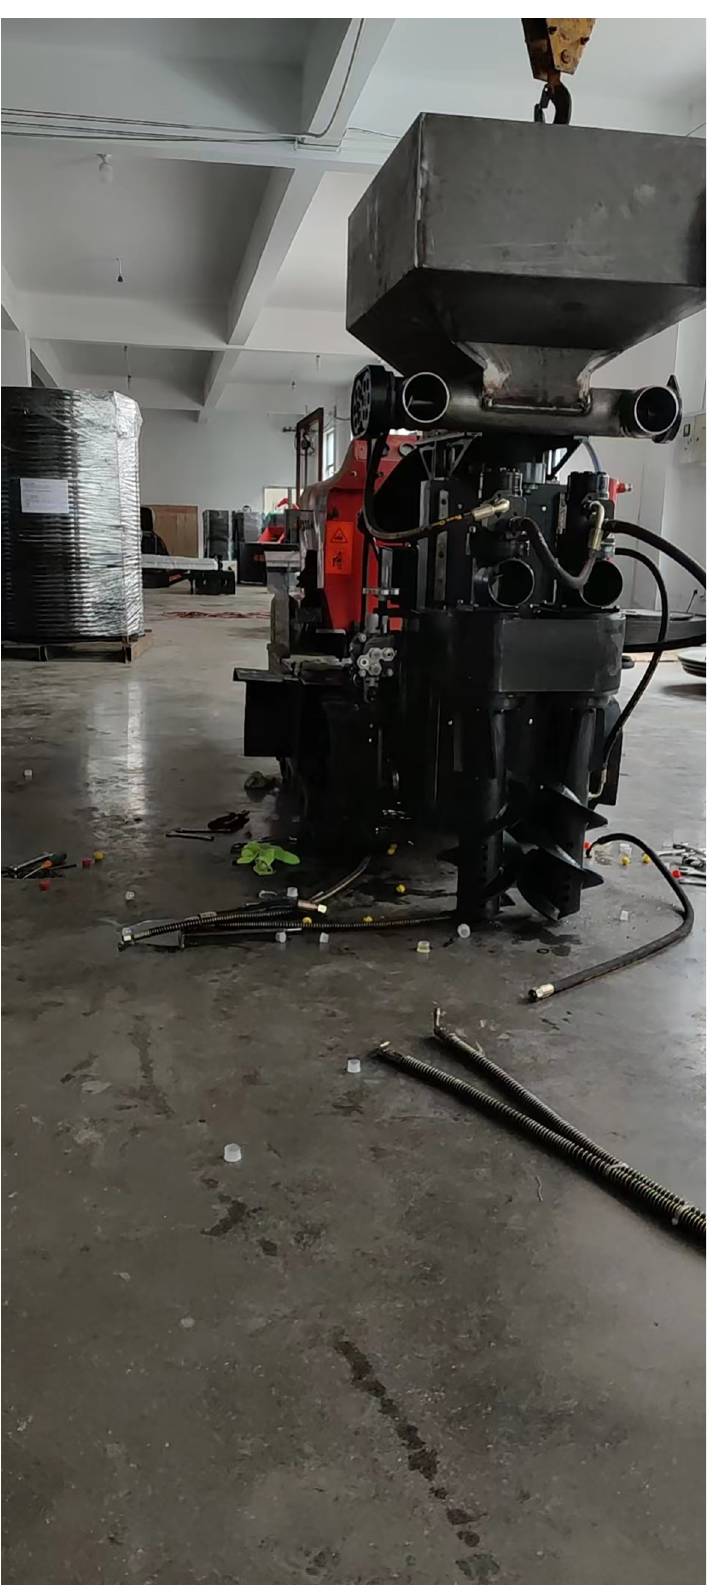
Fig 6. Machining and assembly of fertilizing